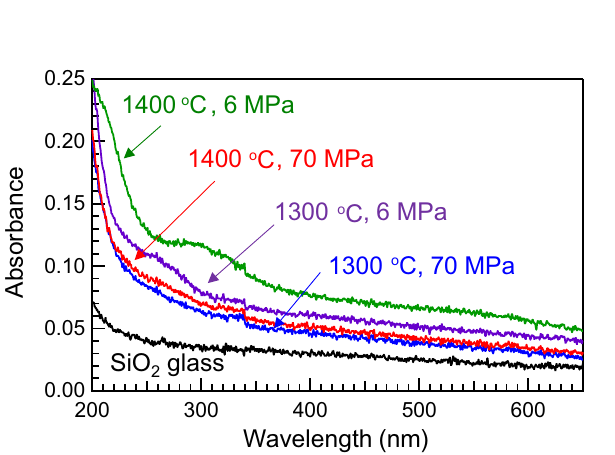
Table 1. Physical properties of the SPS-SiO 2 glasses compared with those of conventional glass.